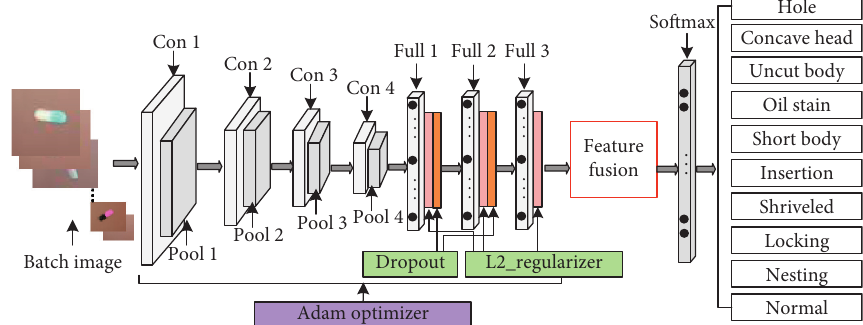
Figure 1: RACNN structural model for capsule